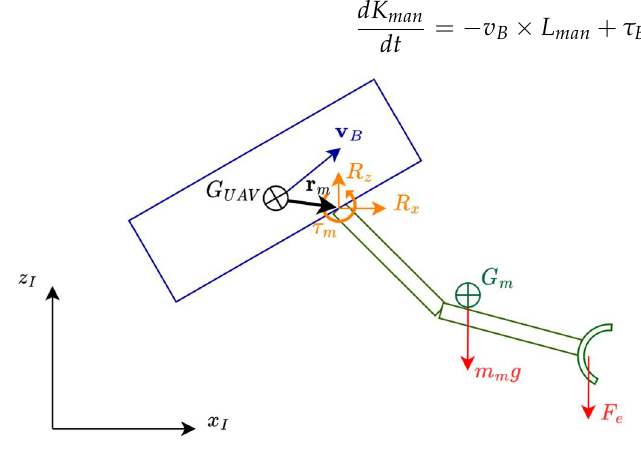
Figure 16. Forces and torques on the manipulator for the extended Jacobian formulation. Centers of gravity are the circles with crosses (black for the UAV, green for the manipulator), external forces are in red, reaction forces/torques in orange.